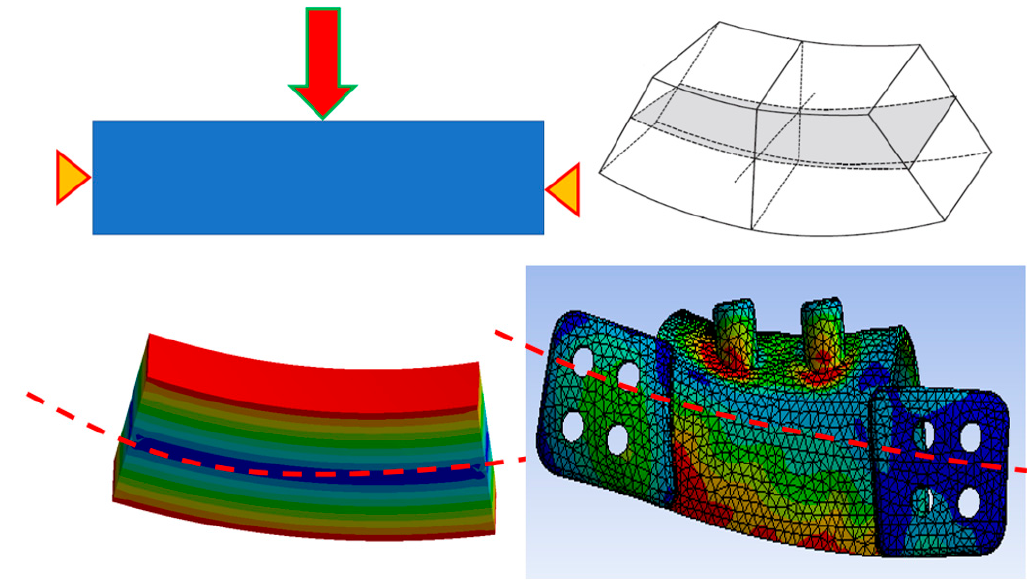
Figure 7. Geometry and loading conditions of the three-points-bending model (upper level) and the stress distributions of the three-points-bending model (lower left) and Model 1 (lower right).